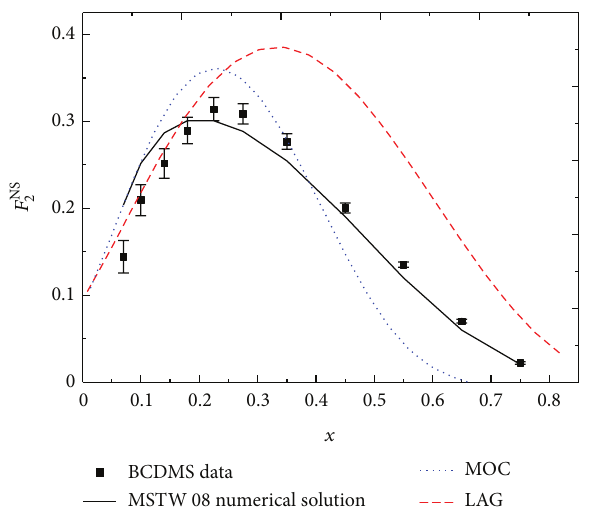
Figure 6: Nonsinglet structure function 𝐹 NS 2 (𝑥,𝑄 2 ) as a function of 𝑥 at different 𝑄 2 values according to (24) and (53). Data from [24].